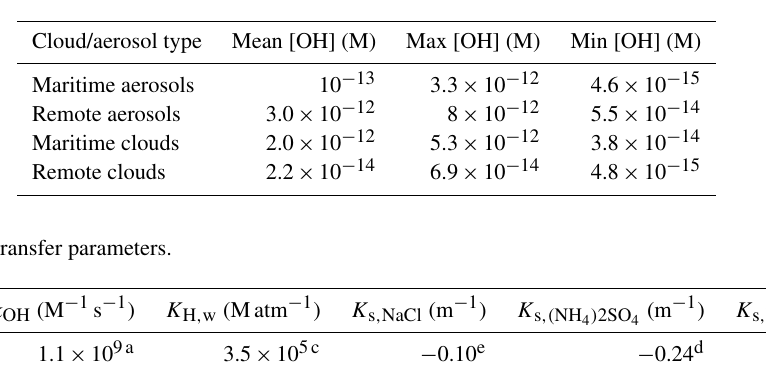
Table 1. Mean values and range of in-particle hydroxyl radical concentrations, as reported by Herrmann et al. (2010).